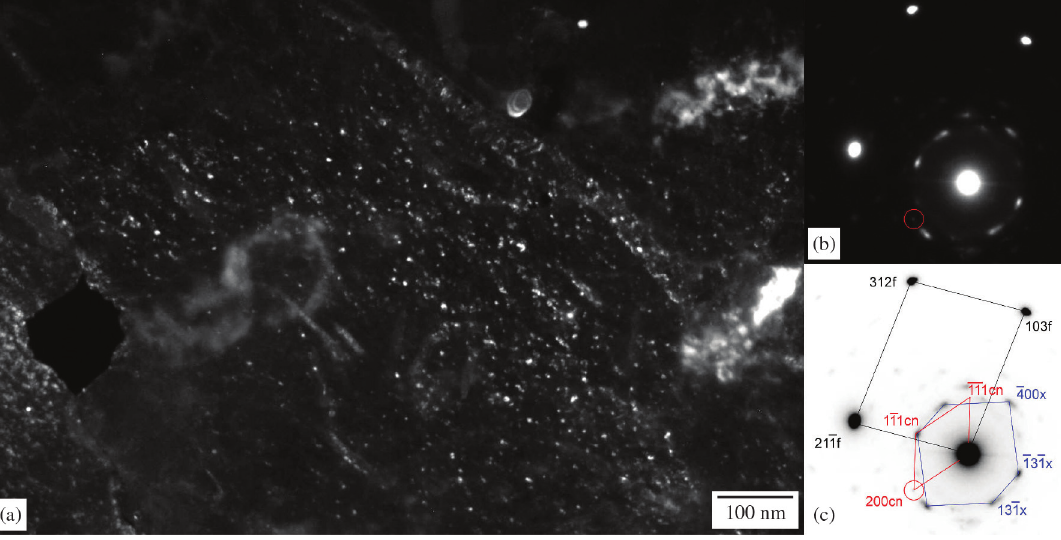
Figure 4. TEM micrograph showing in (a) dark field contrast taken from a {002}cn reflection of finer (Nb,Ti) carbonitrides and respective electron diffraction pattern in (b). Key diagram in (c) suggests that particles were also formed in austenite together some oxidation of iron